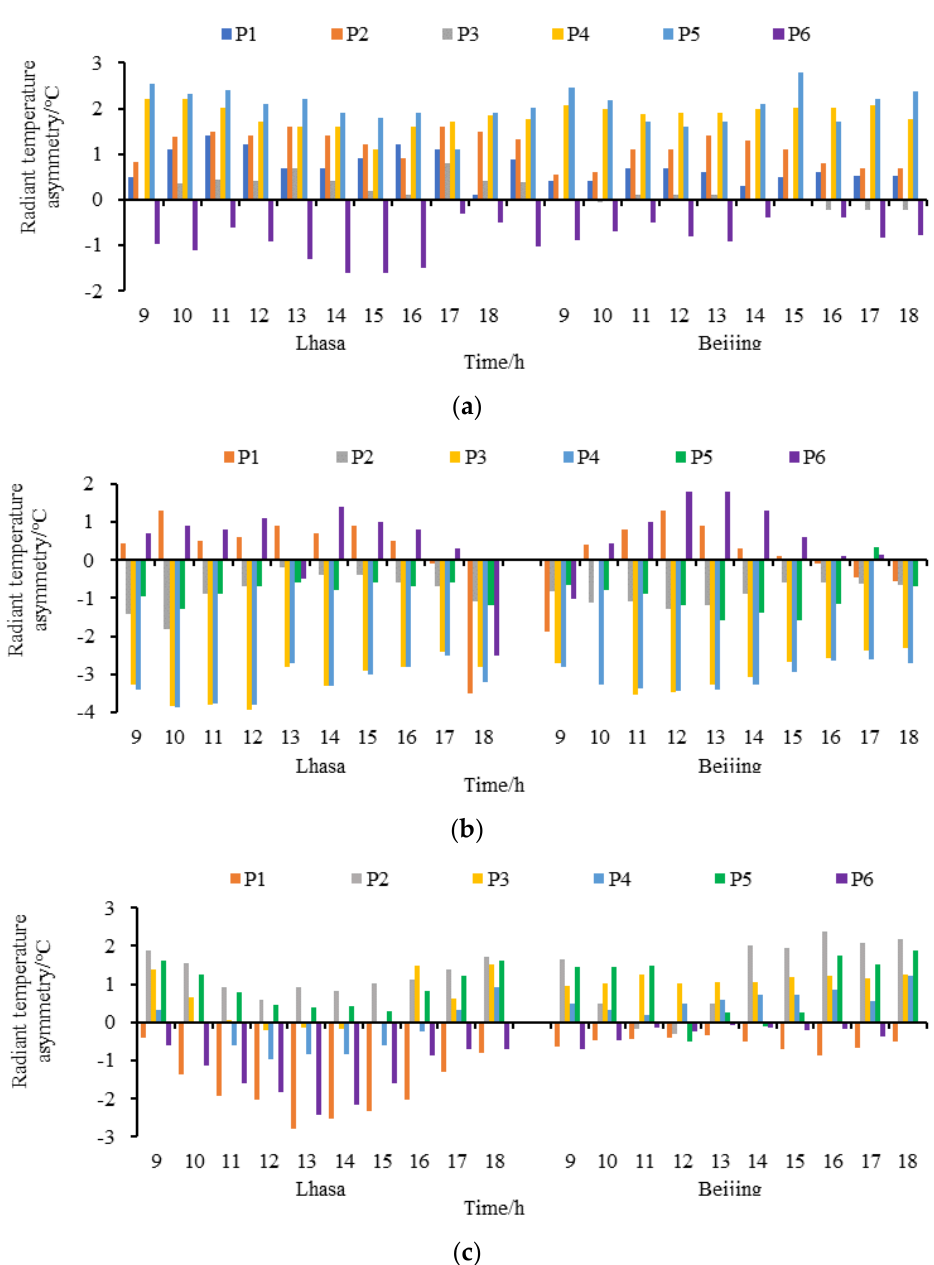
Figure 16. Diurnal variations of RTA in different directions: ( a ) chest and back (X-axis); ( b ) left and right arms (Z-axis); ( c ) head and ankle (Y-axis).